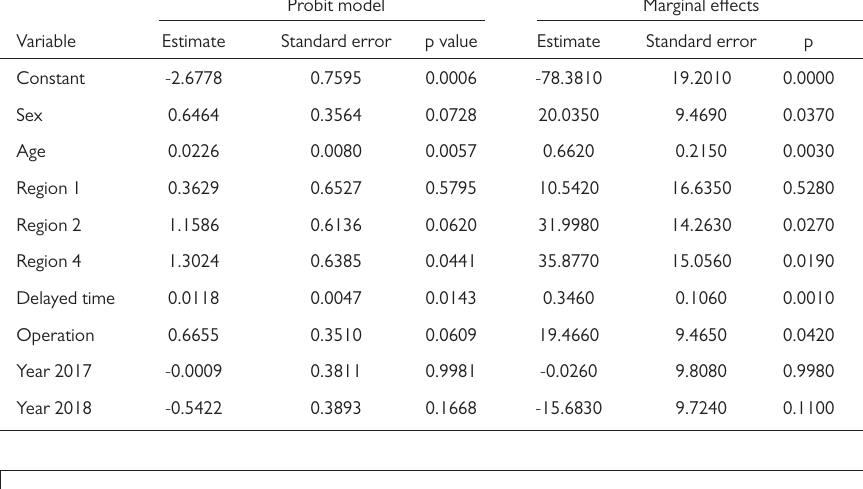
Table 2. Estimates of a probit model and their corresponding marginal effects